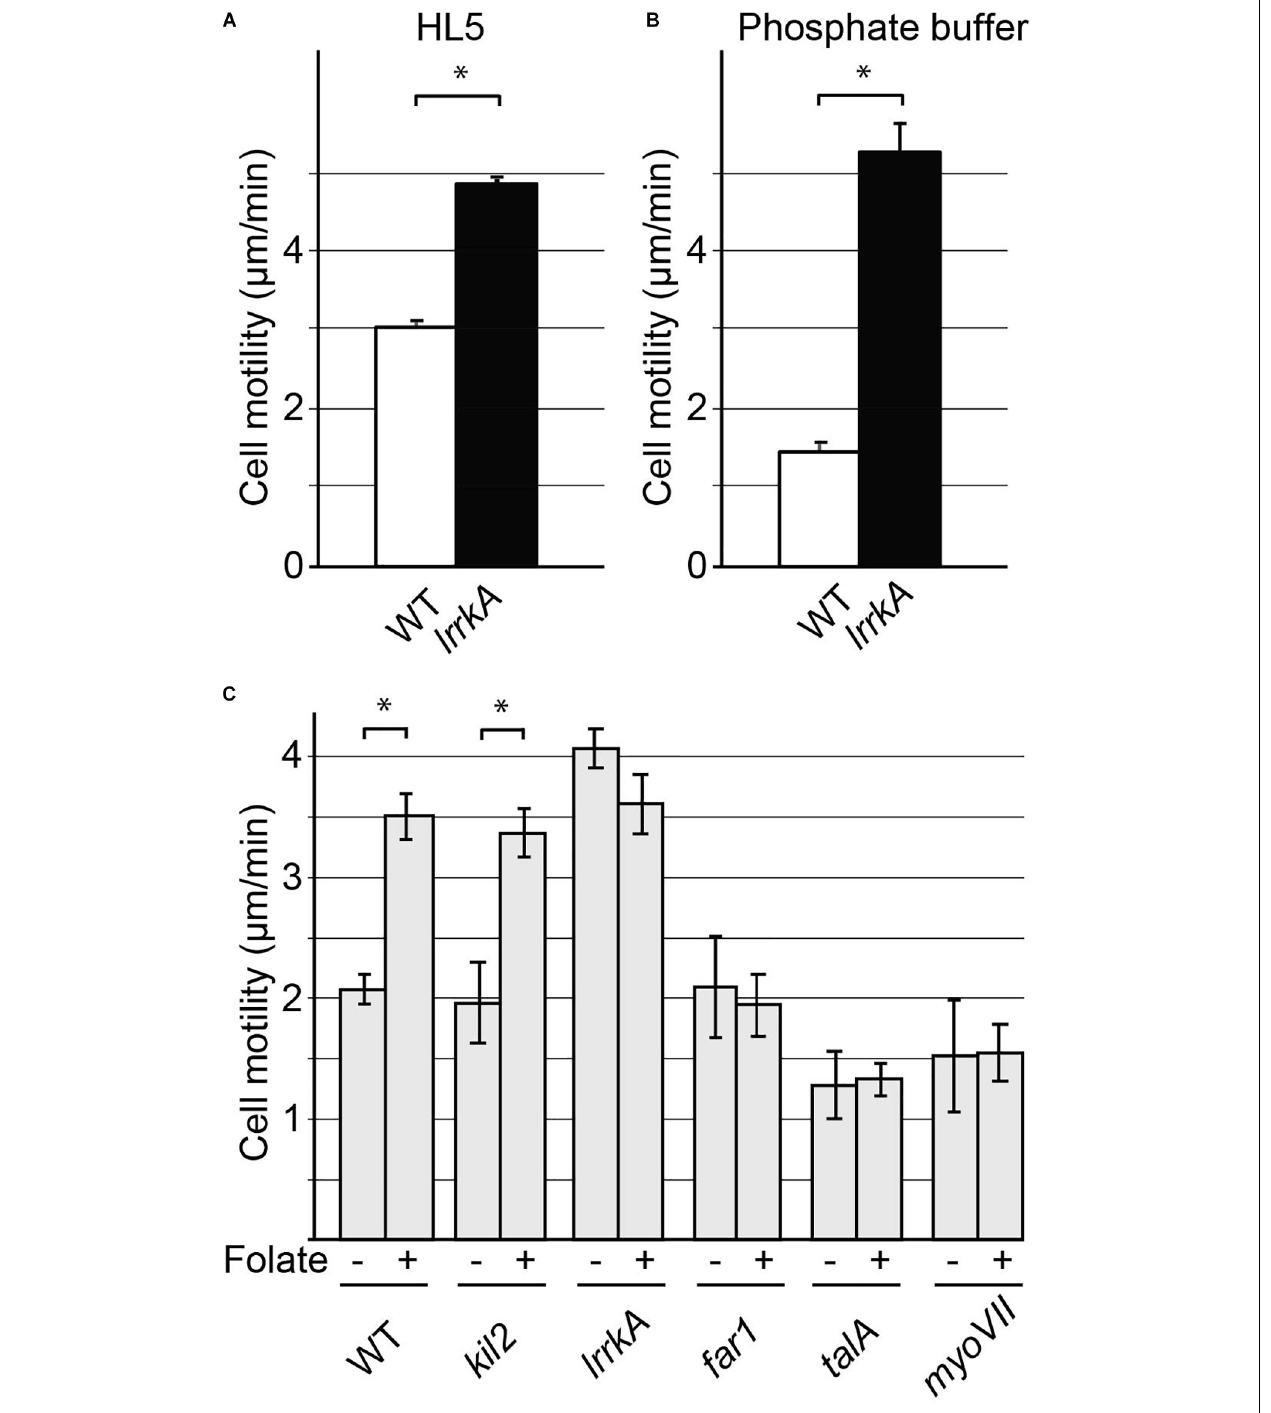
FIGURE 6 | Cell motility is increased by genetic inactivation of lrrkA . Random motility of WT or lrrkA KO cells on a substrate was measured in HL5 (A) and phosphate buffer (B) . Motility was significantly higher in lrrkA KO cells than in WT cells (average ± SEM; ∗ p < 0.01, Student’s t -test, number of cells analyzed in HL5/SB: WT 110/195; lrrkA 363/225; N = 3 independent experiments). Random motility of WT or mutant cells was also measured in phosphate buffer in the presence or absence of folate (C) . Motility increased significantly in WT cells or in kil2 KO cells upon exposure to folate. In lrrkA KO cells, cell motility was high even in the absence of folate, and was not further stimulated upon folate addition. In far1 , talA , and myoVII KO cells, folate failed to stimulate cell motility (average ± SEM; ∗ p < 0.01, Student’s t -test, number of cells analyzed in SB/SB + folate: WT 225/90; lrrkA 315/150; kil2 , far1, talA, myoVII 45/45; N = 3 independent experiments). Distinct experiments are reported in (B) and (C)